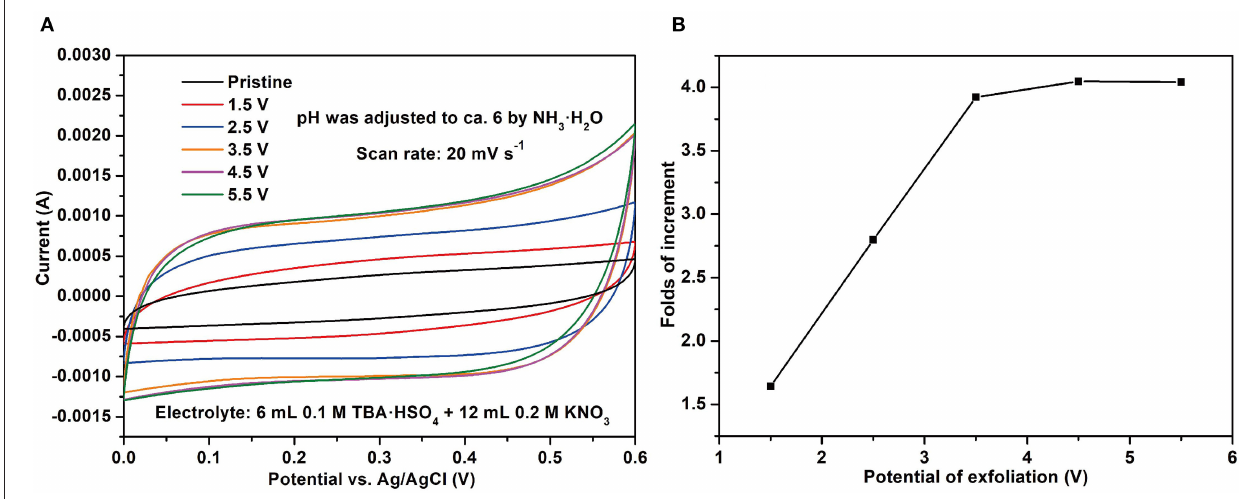
FIGURE 1 | (A) The comparison of CV curves before and after applying the alternating potentials; (B) the folds of increment for CV areas as a function of alternating